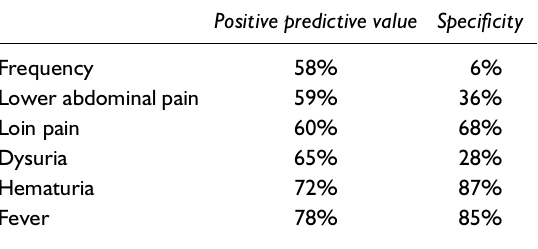
Table 1 Signs and symptoms of urinary tract infection.